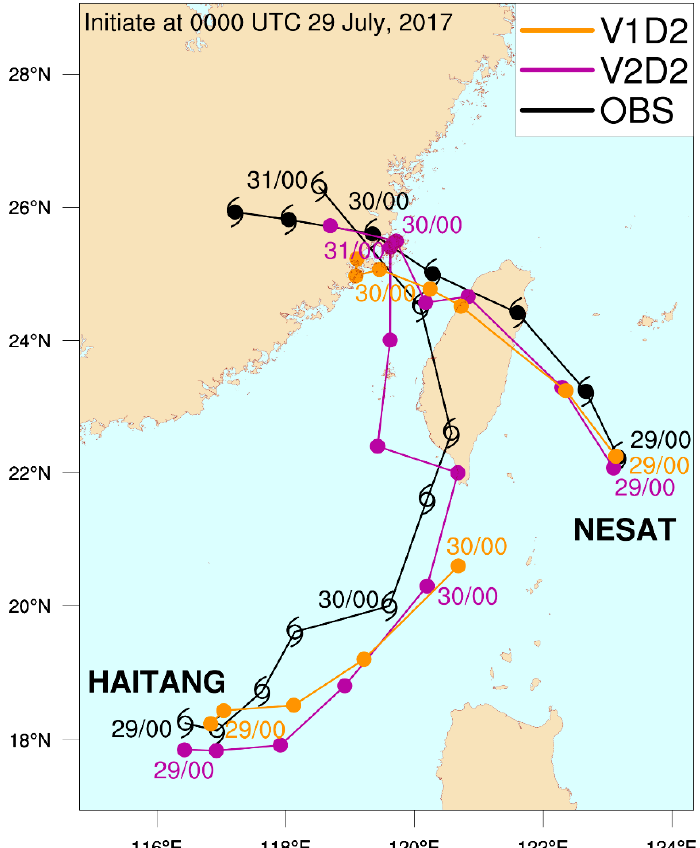
Figure 8. The CWB best tracks and TWRF predicated tracks for Nesat and Haitang starting on 0000 UTC 29 July 2017. Black line with filled typhoon symbols is the observation for Nesat, and open typhoon symbols is for Haitang. The orange lines are the predicted tracks from V1D2, and the purple lines are from the V2D2.